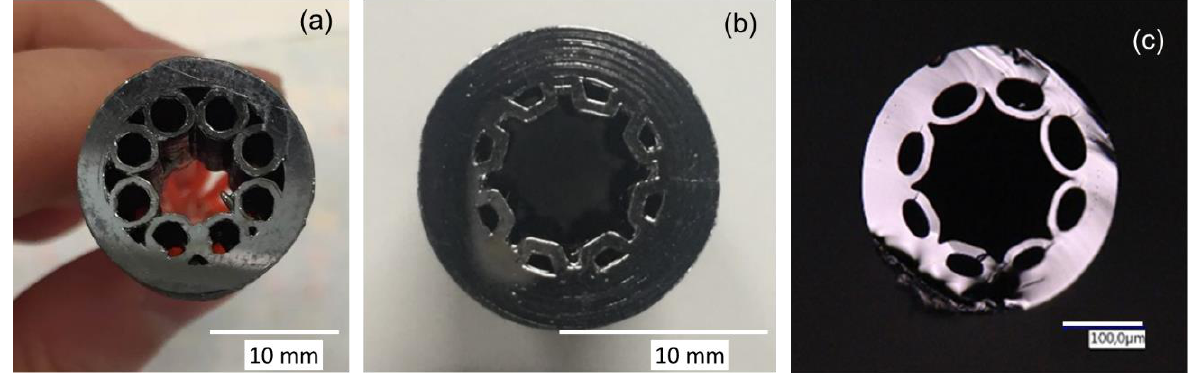
Figure 8. Printed preforms: ( a ) cross-section view of the chalcogenide printed 8 capillaries preform and ( b ) cross-section view of the chalcogenide printed 8 half-capillaries preform ( c ) cross section of a hollow core fiber drawn from the preform shown in ( b ).